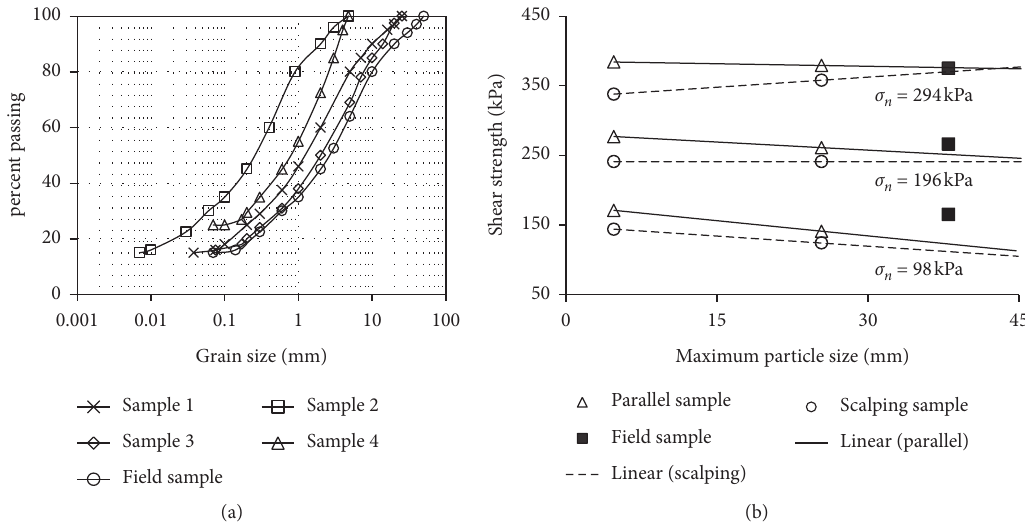
Figure 12: (a) Distribution curves of four samples and a field sample; (b) variation of shear strength as a function of d scalping, and field samples under different normal stresses (data taken from